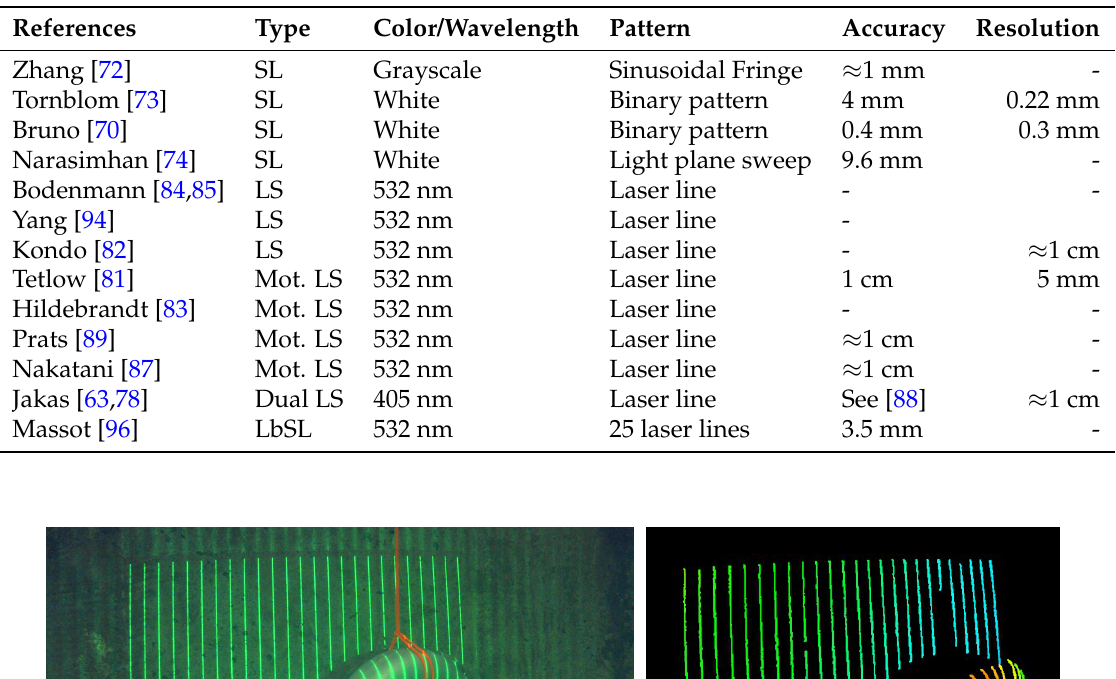
Table 4. Summary of structured light 3D reconstruction solutions.